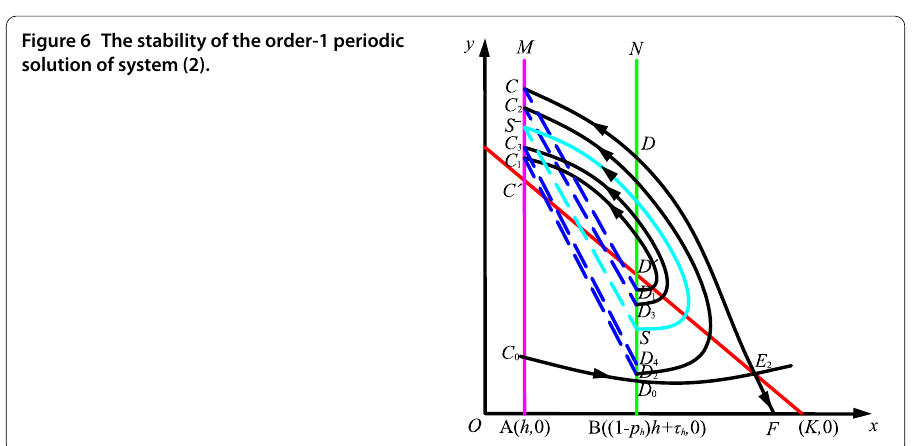
Figure 6 The stability of the order-1 periodic solution of system